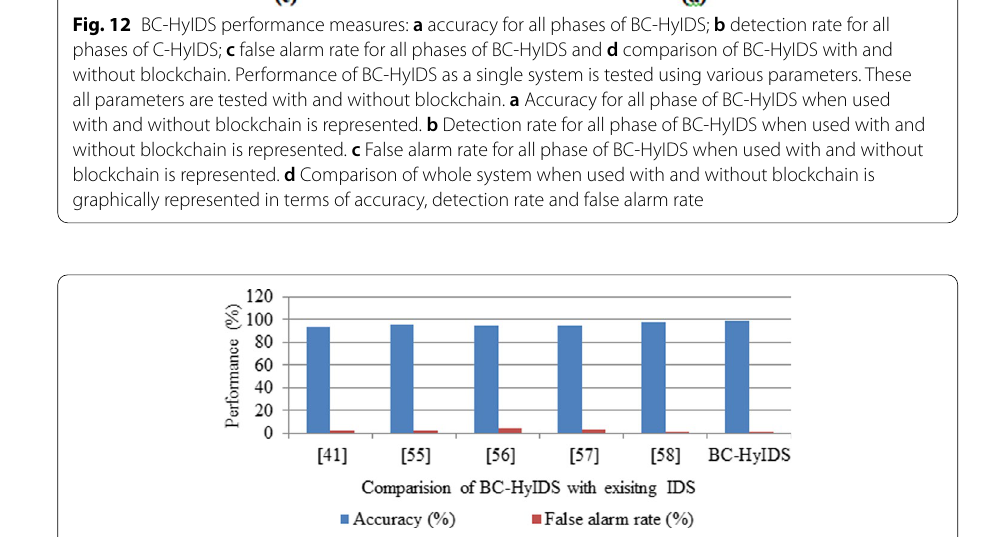
Fig. 13 Comparison of BC-HyIDS with existing IDS. Proposed BC-HyIDS with blockchain as a whole system is compared with existing hybrid IDS. Graphical representation shows better performance of BC-HyIDS as compared to existing IDS for distributed